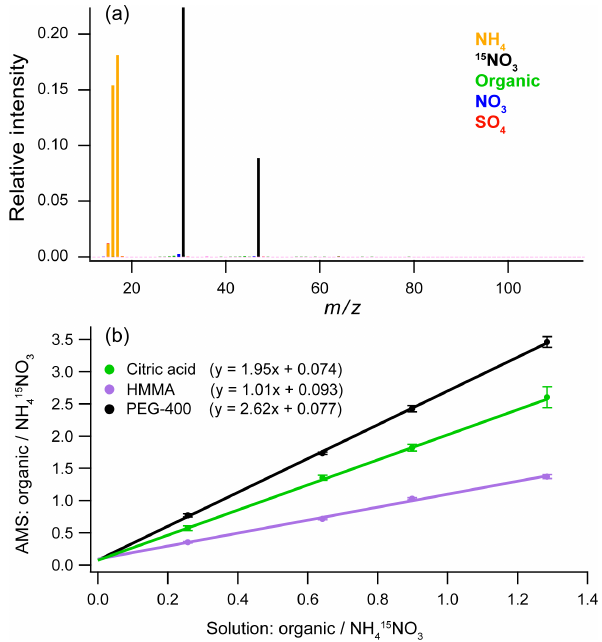
Figure 4. (a) Blank of the Kapton film using 1gL − 1 internal stan- dard solution ( 15 N – ammonium nitrate). (b) Calibration curves made using an internal standard for solutions with three different or- ganic compounds: citric acid, 4-hydroxy-3-methoxy-DL-mandelic acid (HMMA), and polyethylene glycol 400 (PEG-400). The error bars are ± 1 σ for five replicate